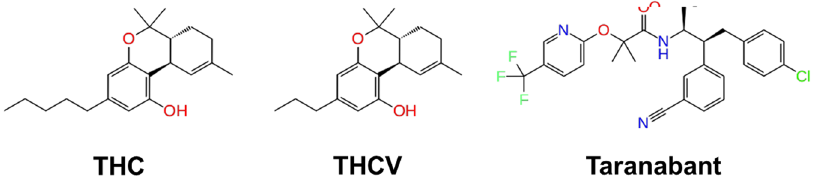
Figure 1. Chemical structure of the partial agonist THC, antagonist THCV, and inverse agonist Taranabant.